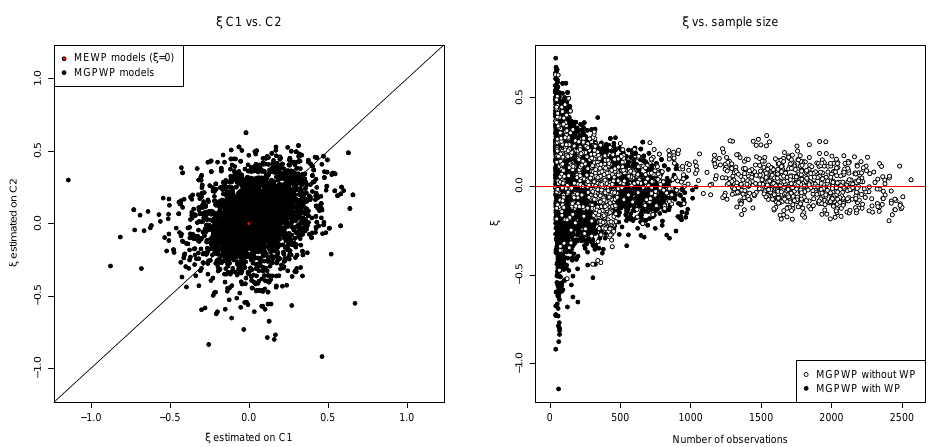
Figure 8. Left: estimated ξ s on C ( 1 ) and C ( 2 ) for the four MGPWP models, with α = 0 . 5 (one point per station). MEWP models correspond to ξ = 0 (red points). Right: same ξ s as a function of the sample size with WP (black points) and without WP (white points) (one point per station and period).